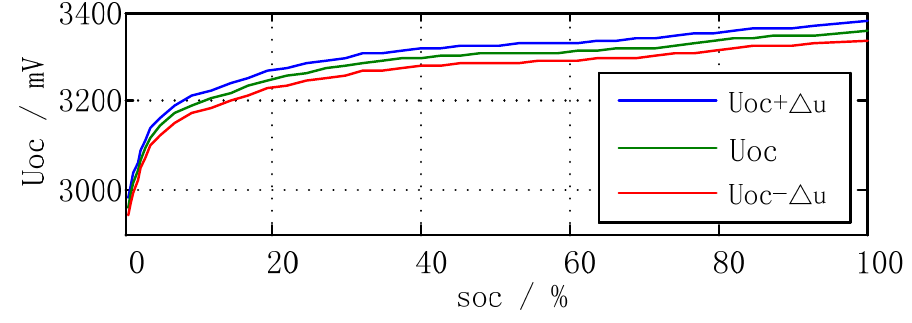
Figure 11. SOC-OCV curve adjusted intentionally.